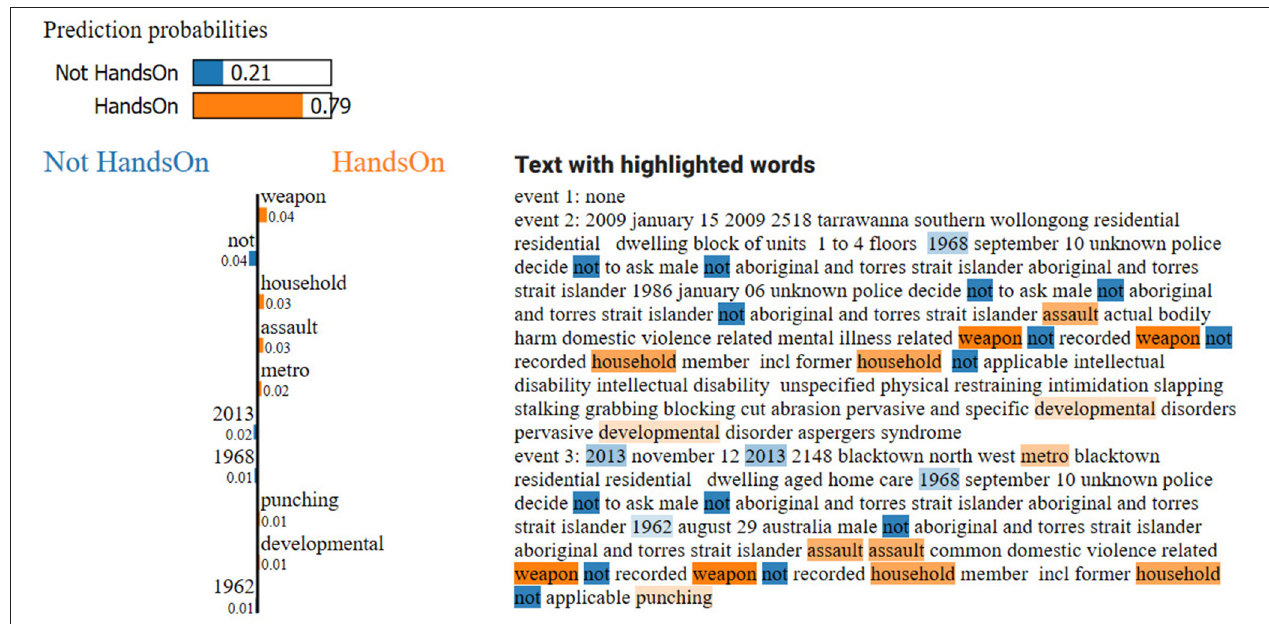
FIGURE 8 | Interpretable explanation from LIME for an instance of predicting a “hands-on” offense type based on two previous FDV events. Top-left are the prediction probabilities generated by the BERT model; a graph displaying the top 10 words that contribute to the negative class “not hands-on” (blue) and the positive class “hands-on” (orange) and their weights of influence is shown on the left; text data with the top 10 words highlighted (darker-colored highlights have larger weights) are on the